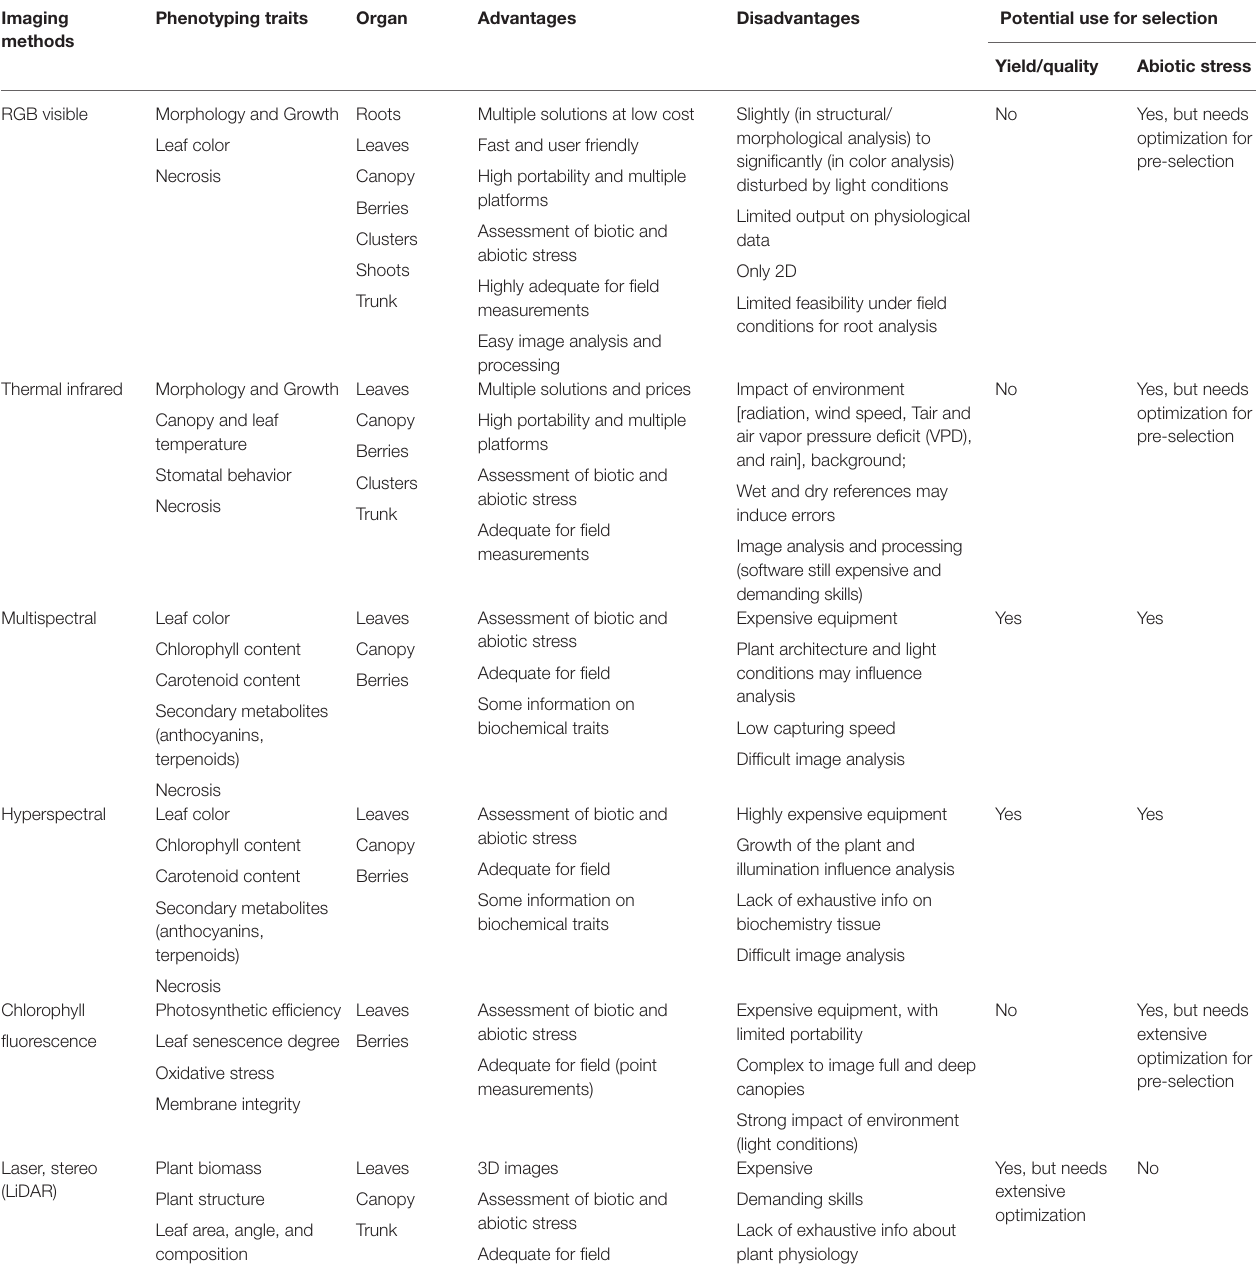
TABLE 1 | List of imaging methodologies, their advantages, disadvantages, and potential application to screen grapevine plants in field conditions (genotype selection for yield, berry quality, and for abiotic stress). Imaging Phenotyping methods